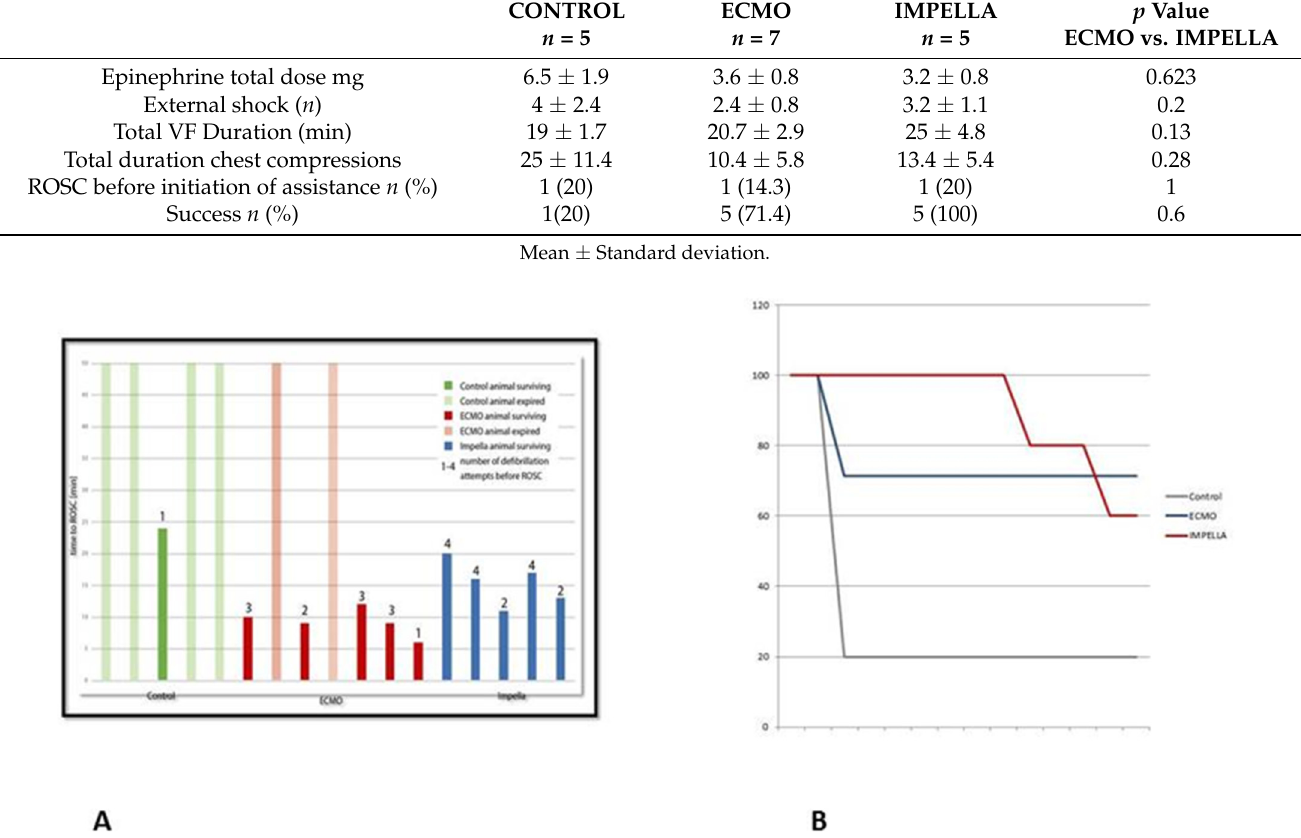
Figure 2. ROSC delay and achievement ( A ) and Survival ( B